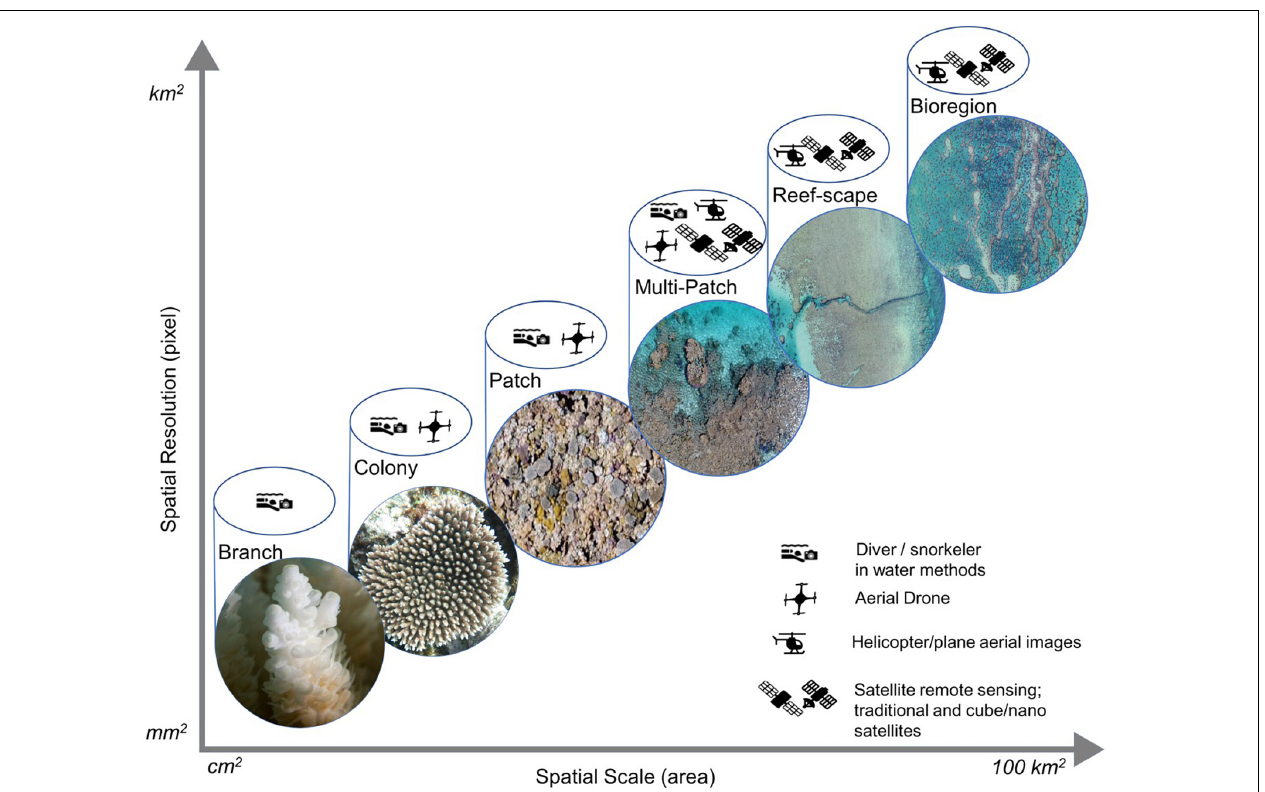
FIGURE 3 | The spatial scale being measured and spatial resolution of the data is depicted as a linear relationship. Here we demonstrate the remote sensing method best suited to collect suitable data at major coral reef ecological scales. (Photo credits: “Branch”: N. Thake – AIMS; “Colony,” “Patch,” “Multi-Patch”: S. Hickey; “Reef-scape,” “Bioregion”: